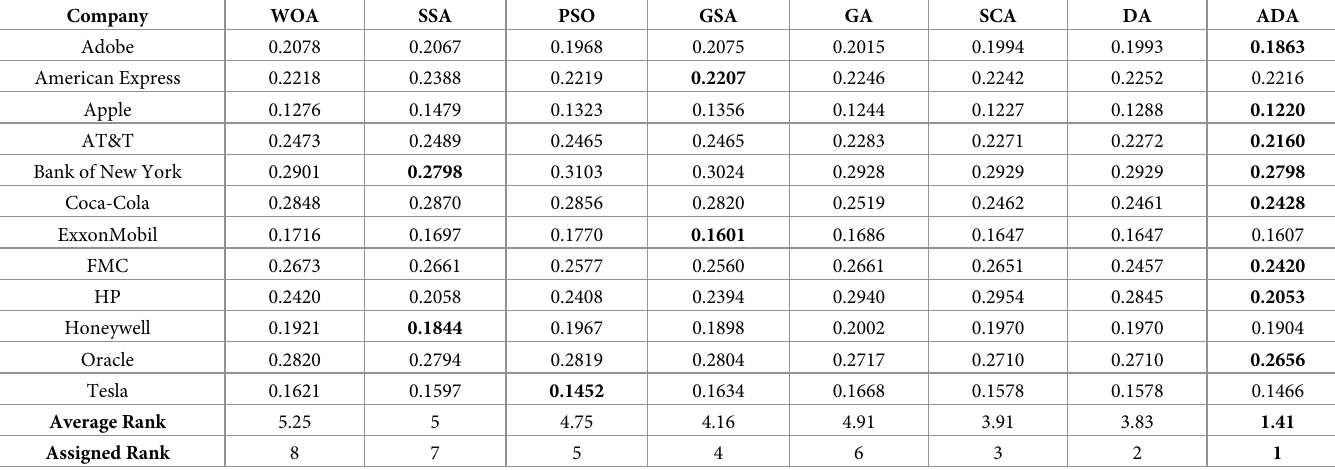
Table 2. Values of the fitness function for different algorithms run on various companies’ datasets.